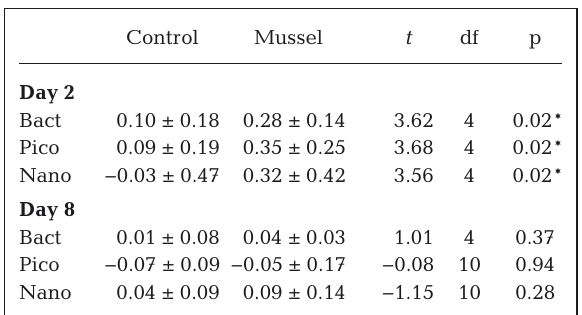
During the recovery period, net growth rates (k) were calculated after 2 d (2011) and 8 d (both years; Eq. 3). The peaks in concentration previously de - scribed were reflected in the net growth rates (µg d −1 ); 2 d after mussel filtration had ended, bacteria and pico- and nanophytoplankton responded with an increased growth rate, while after 8 d, this effect of filtration had disappeared (Table 4). Table 4. Net growth rate (d −1 , mean ± SD) for bacteria, pico- and nanophytoplankton in both the control and blue mussel Mytilus edulis mesocosms, on Days 2 and 8 during the recovery period. Day 2 net growth rates as well as bacterial net growth rates were only determined for 2011. Results from the paired t -test to detect differences between the 2 treatments are given; *denotes a significant (p < 0.05)